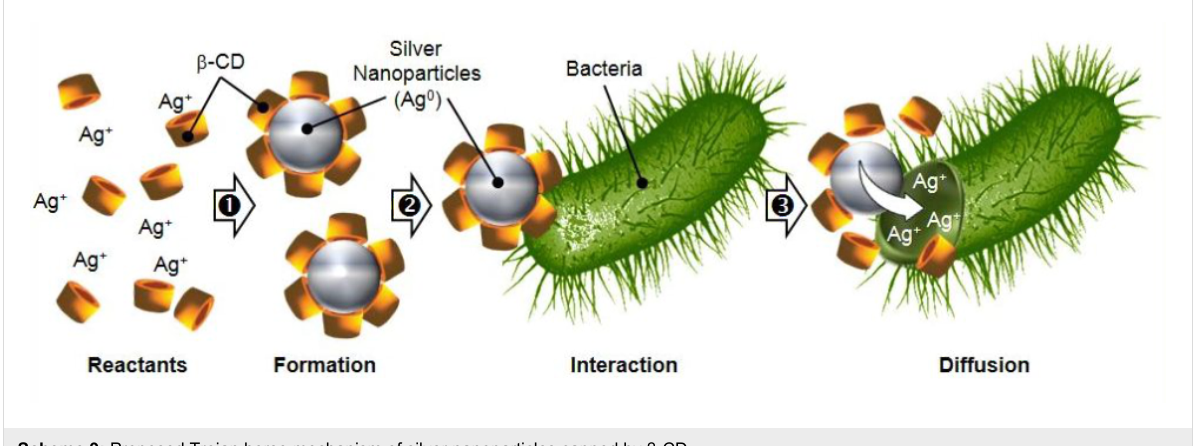
Scheme 9: Proposed Trojan horse mechanism of silver nanoparticles capped by β